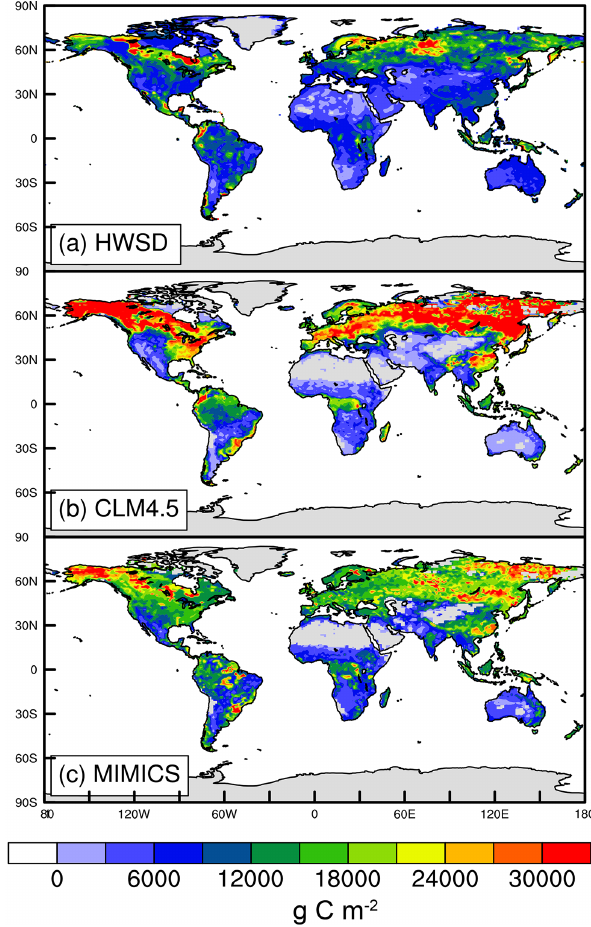
Figure 4. Global soil C pools (gCm − 2 , 0–100cm) from observations and models. (a) Observations from the Har- monized World Soils Database and global total = 1260PgC. (b) CLM4.5 global total = 1780PgC (spatial correlation with ob- servations ( r ) = 0.42, model-weighted root mean square error (RMSE) = 13.7kgCm − 2 ). (c) MIMICS global total = 1530PgC ( r = 0 . 46, RMSE = 6.8kgCm − 2